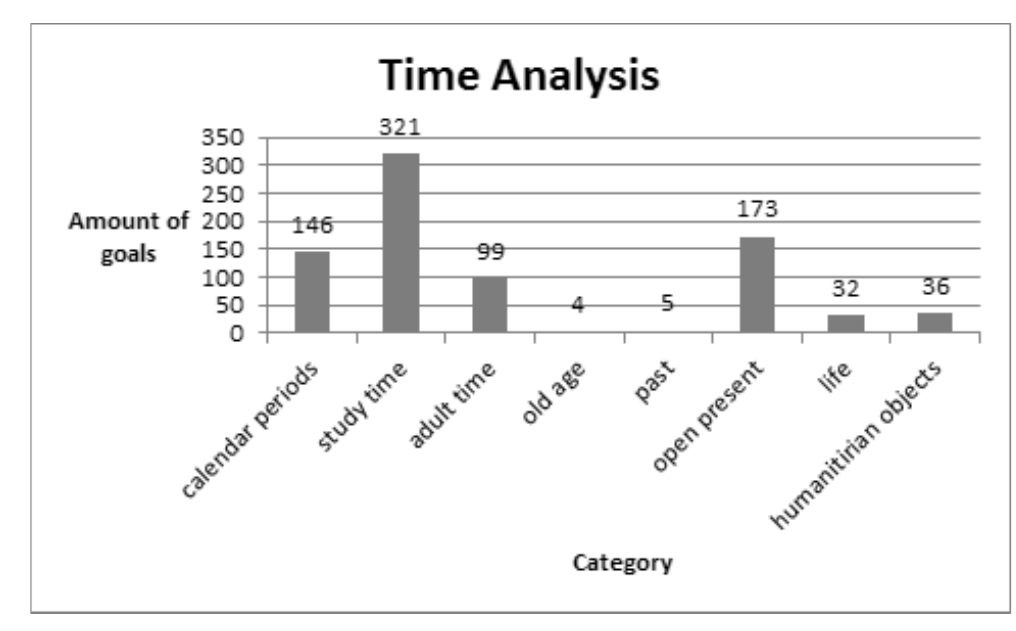
Figure 2. Time Analysis of